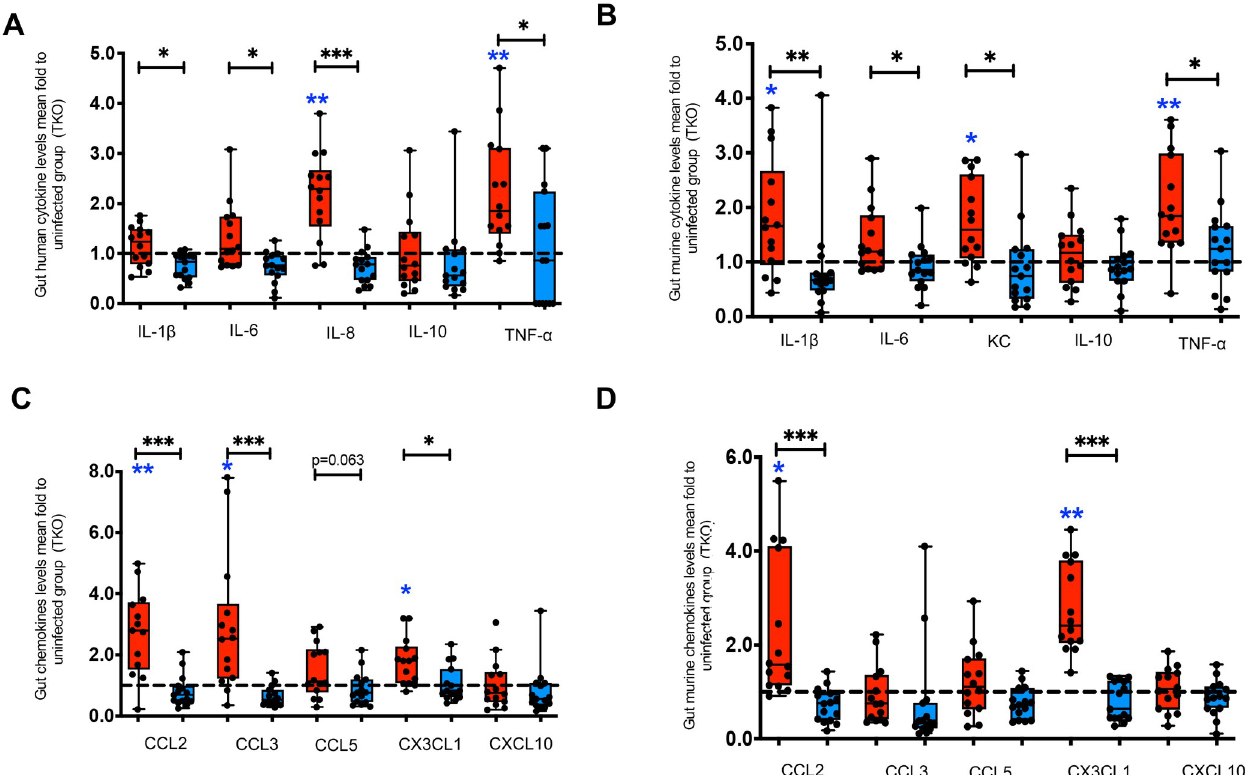
Fig 2. Tg6F attenuates gut inflammation in humanized mice with treated HIV infection. TKO C57 (n = 37) humanized (BLT) mice were constructed, infected and treated with antiretroviral therapy (ART) and control transgenic tomato concentrate and/or oral ApoA-I mimetic peptide 6F in the form of transgenic tomato (Tg6F). The small intestine from each mouse was collected and protein lysates were prepared from BLT mice after 16 weeks of HIV infection in the HIV + ART + group. Human and murine cytokines [interleukin (IL)-1 β , IL-6, IL-8, IL-10, tumor necrosis factor alpha (TNF- α )] and chemokines [C-C Motif Chemokine Ligand 2 (CCL2), CCL3, CCL5, C-X3-C Motif Chemokine Ligand 1 (CX3CL1), C-X-C Motif Chemokine Ligand 10 (CXCL10)] were determined in gut tissue lysates by Luminex immunoassays after 16 weeks of HIV infection in the HIV + ART + group. The mean value of each measurement in HIV + ART + (red color)(n = 14) and HIV + ART + /Tg6F + (blue color)(n = 15) mice BLT mice was expressed as fold to the mean value of each measurement in uninfected (n = 8) BLT mice (within the same cohort). A. Fold changes of human cytokines in gut tissue lysates of HIV + ART + and HIV + ART + /Tg6F + TKO mice compared to uninfected BLT mice. B. Fold changes of murine cytokines in gut tissue lysates of HIV + ART + and HIV + ART + / Tg6F + TKO mice compared to uninfected BLT mice. C. Fold changes of human chemokines in gut tissue lysates of HIV + ART + and HIV + ART + /Tg6F + TKO mice compared to uninfected BLT mice. D. Fold changes of murine chemokines in gut tissue lysates of HIV + ART + and HIV + ART + /Tg6F + TKO mice compared to uninfected BLT mice. Data represent box and whiskers with minimum, median and maximum values ( n = 8–15 mice per group). Datapoints represent mean of at least 2 experimental replicates per mouse. The Kruskal Wallis was used to compared > 2 groups and the Mann-Whitney test was used to compare 2 groups ( � p < 0.05, �� p < 0.01, ��� p < 0.001). The asterisks in blue demonstrate the comparison relative to the uninfected